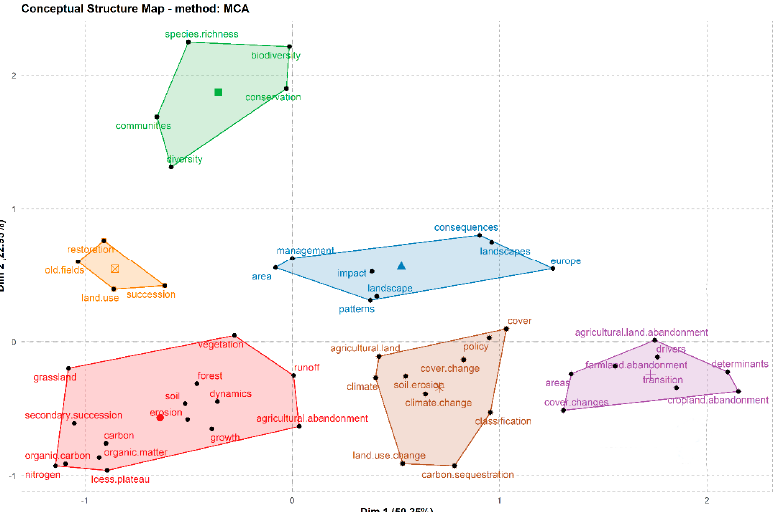
Figure A1. Number of independent and cooperative publications in the 20 countries with the most published articles from 1980 to 2021 .